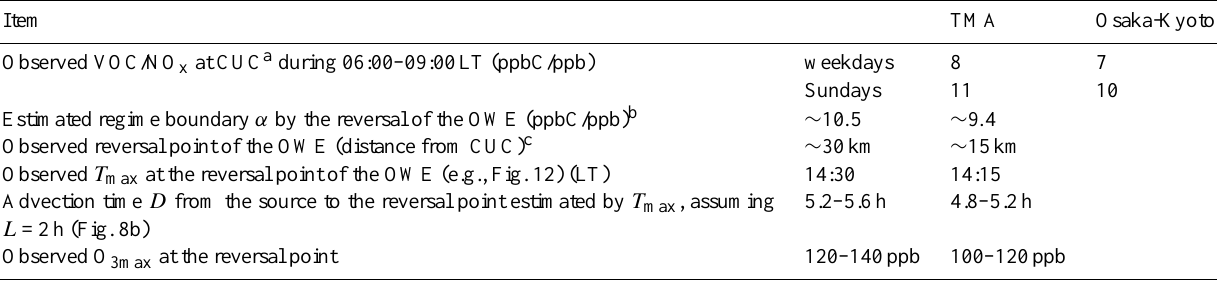
Table 2. Values of several parameters estimated from the observed reversals of the OWE in the TMA and Osaka-Kyoto areas at the 98th percentile rank of O 3max . Item TMA Osaka-Kyoto Observed VOC/NO x at CUC a during 06:00–09:00LT (ppbC/ppb) weekdays 8 7 Sundays Estimated regime boundary α by the reversal of the OWE (ppbC/ppb) b ∼ 10 . 5 ∼ 9 . 4 Observed reversal point of the OWE (distance from CUC) c ∼ 30km ∼ 15km Observed T max at the reversal point of the OWE (e.g., Fig. 12) (LT) Advection time D from the source to the reversal point estimated by T max ,